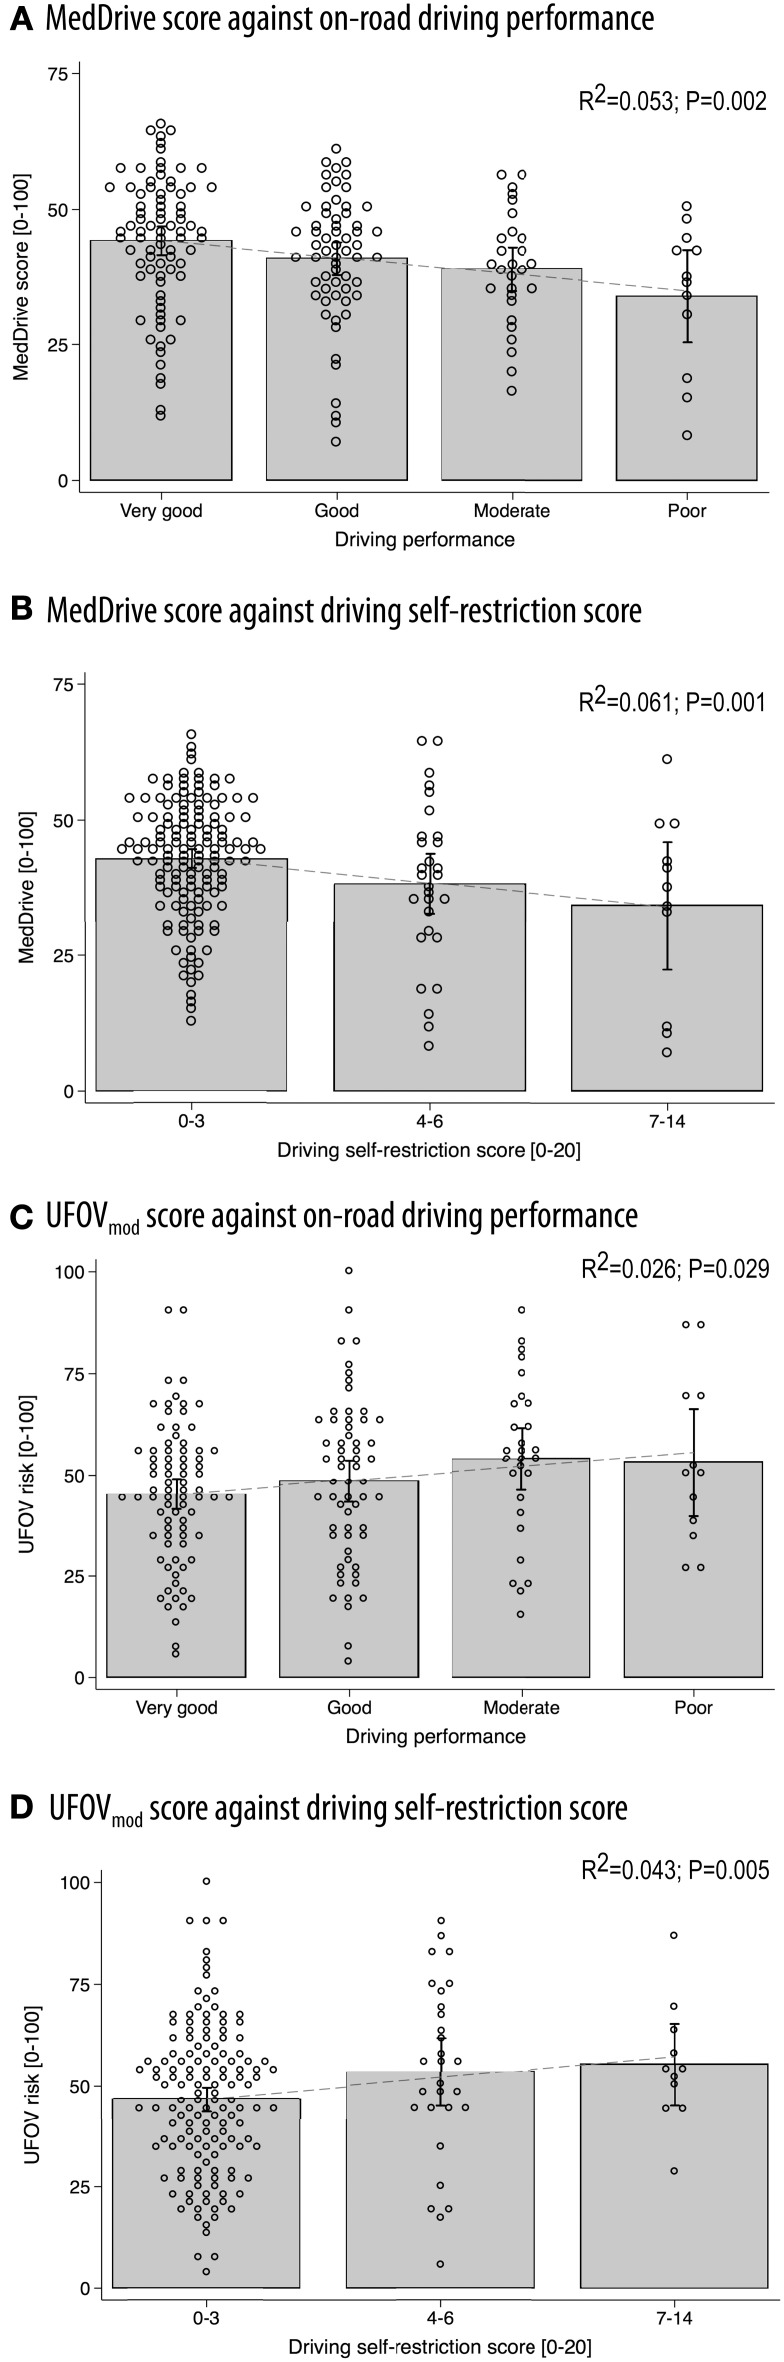
Concurrent validity between MedDrive and the UFOV in predicting on-road driving performance or driving self-restrictions. Correlations between MedDrive and on-road driving performance (A) and driving self-restriction score (B) on 182 older drivers. Concurrent validity was evaluated by providing the UFOV's correlations to the same measures of driving behavior (C,D). Dots correspond to each individual observation. Gray blocks' upper borders correspond to mean observed score values. Interval bars represent 95% CI. Dotted lines represent the best fit regression line. UFOVmod was generated from log transformed values of visual processing, divided attention, and selective attention using SEM. This overall score was then transformed to range from 0 to 1. This method fitted driving behavior better than did the standard UFOV risk category method and made comparison with MedDrive more even. P-values correspond to LRtest statistics for R2 = 0. UFOV, useful field of view; R2, coefficient of determination; SEM, structural equation modeling.